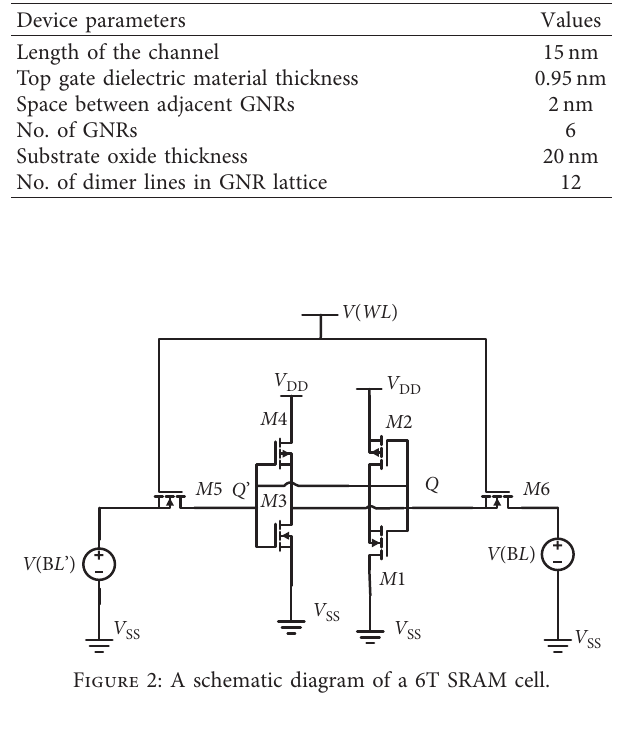
Table 1: Device parameters of graphene nanoribbon field-effect transistor.